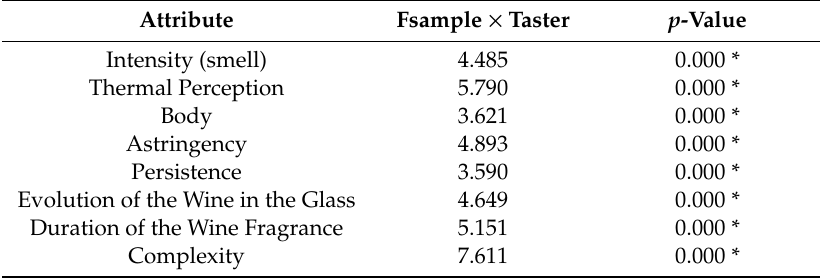
Table 2. Values of F sample × taster and significance levels for the sensory attributes of the white